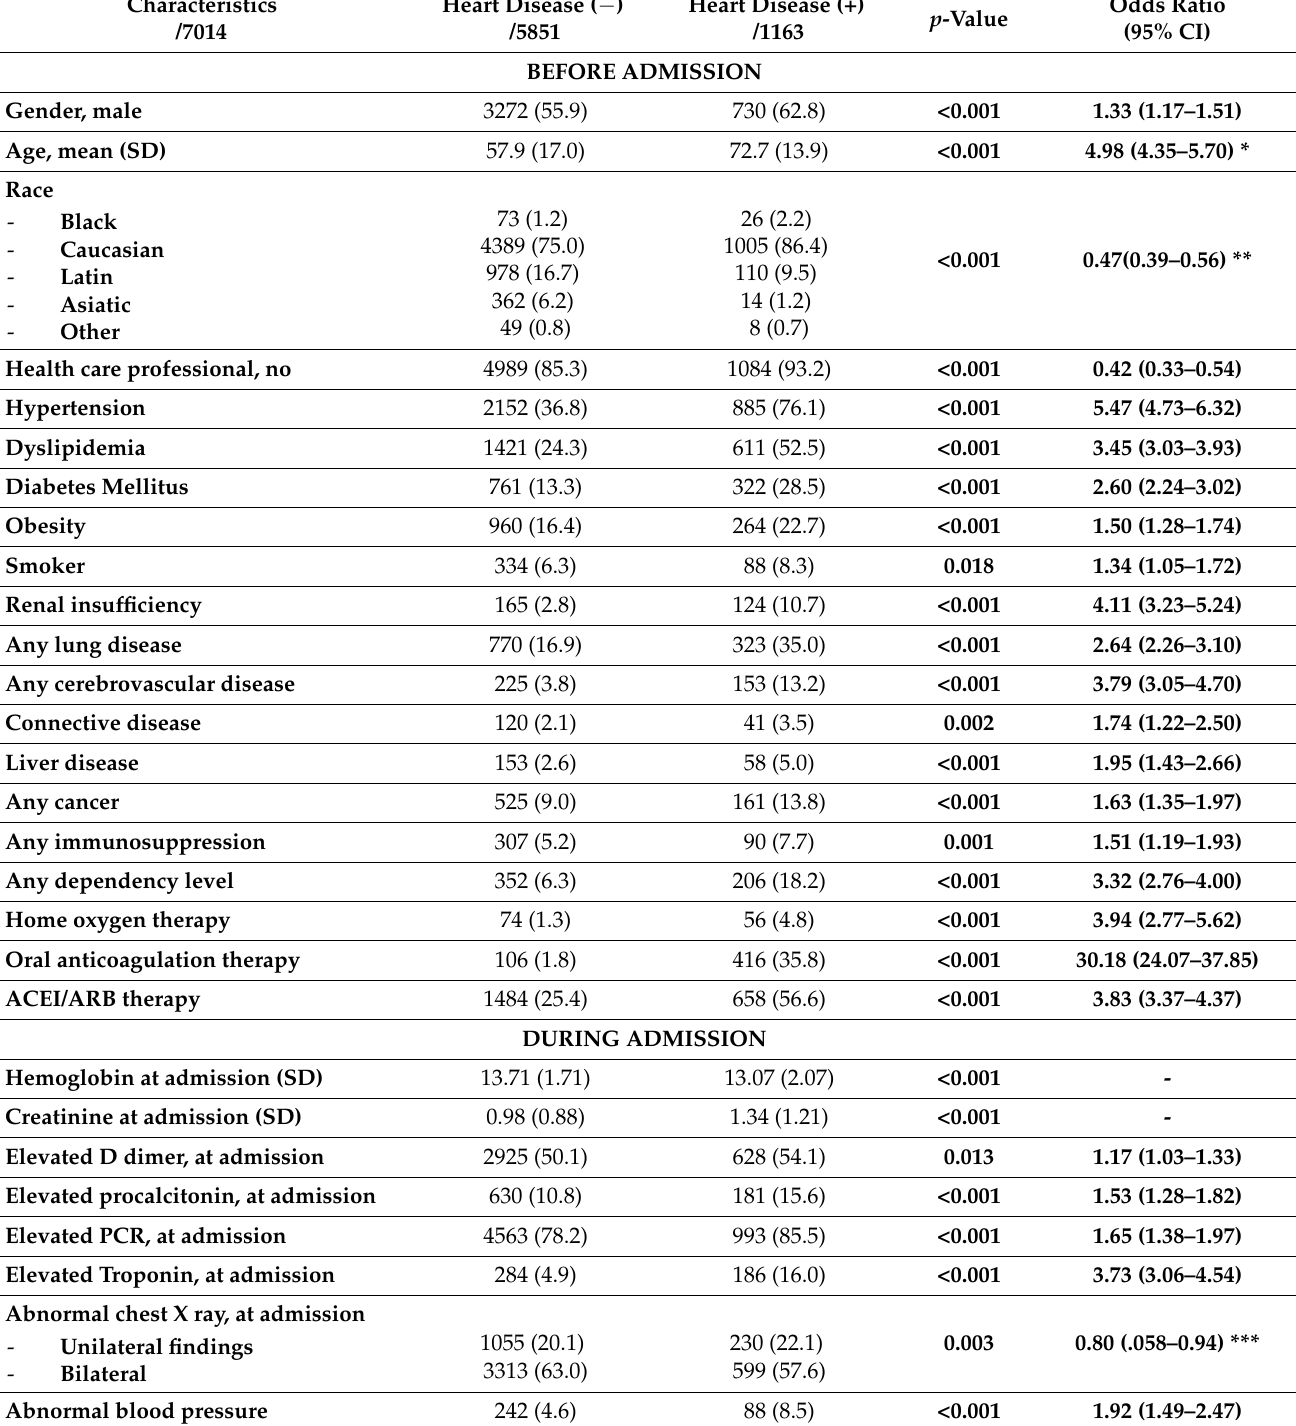
Table 1. Clinical features before admission, discharge management, vaccination, and vital status stratified by heart disease. Data presented over available registries in each variable (percentages). All these patients were discharged alive. Univariate risk estimators (odds ratio (OR) and the